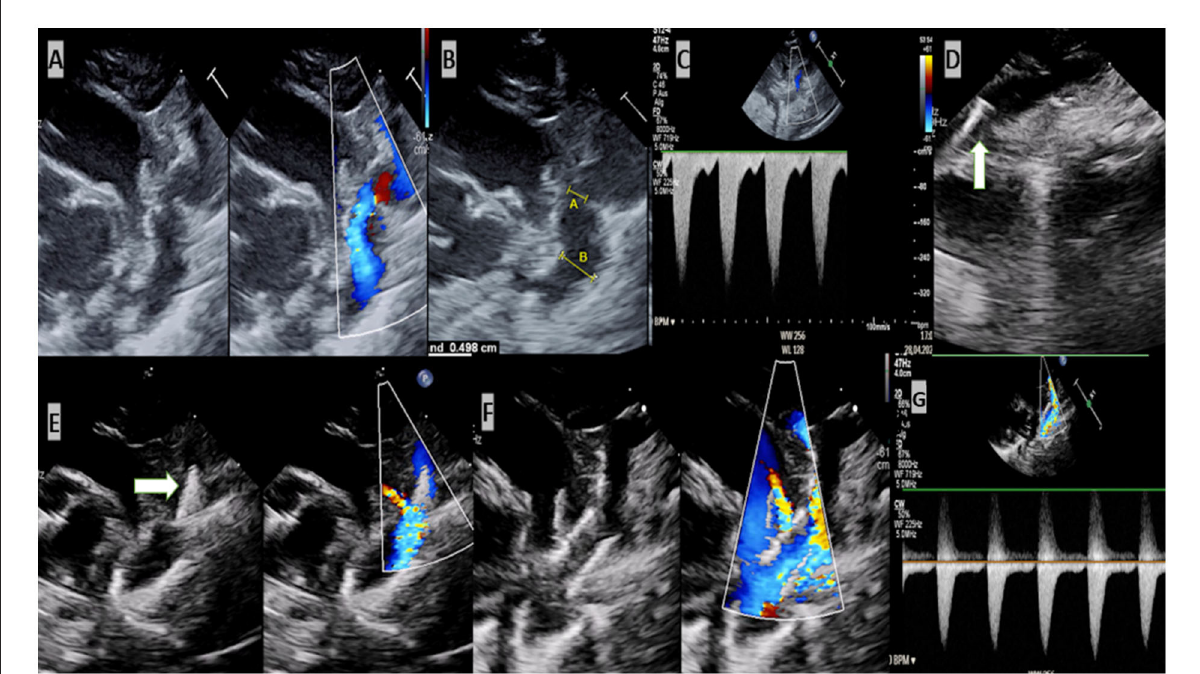
FIGURE1 Echocardiogram-guided stenting of critical aortic coarctation. (A) Critical coarctation of aorta. (B) Measurement required for intervention [ (A) the diameter of the stenosis and (B) is the diameter of the descending aorta]. (C) Increased velocity of blood in the region of stenosis. Insertion of the wire in the descending aorta. (D) Stent was positioned in the isthmus. (E) Stent was implanted. (F,G) Normal velocity of blood after implantation of